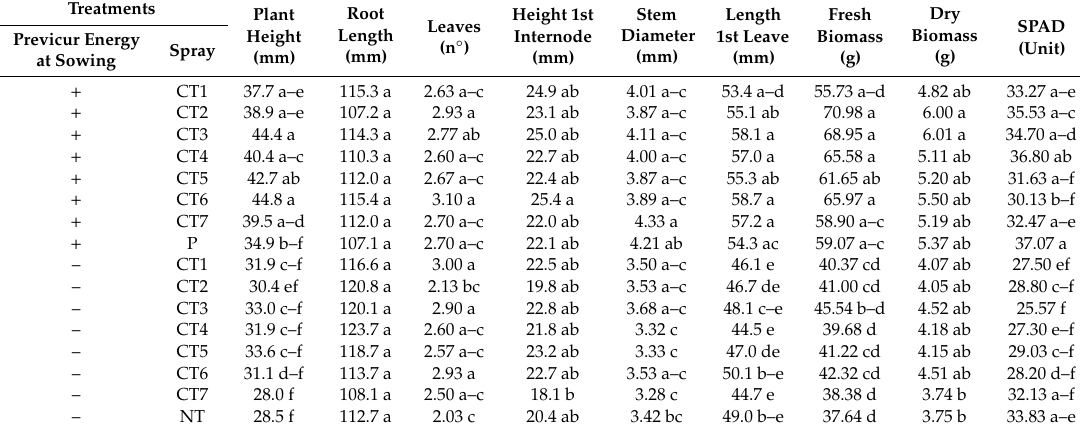
Table 6. Biometric assessments and SPAD values of melon plants under CTs (CT1–7) spray